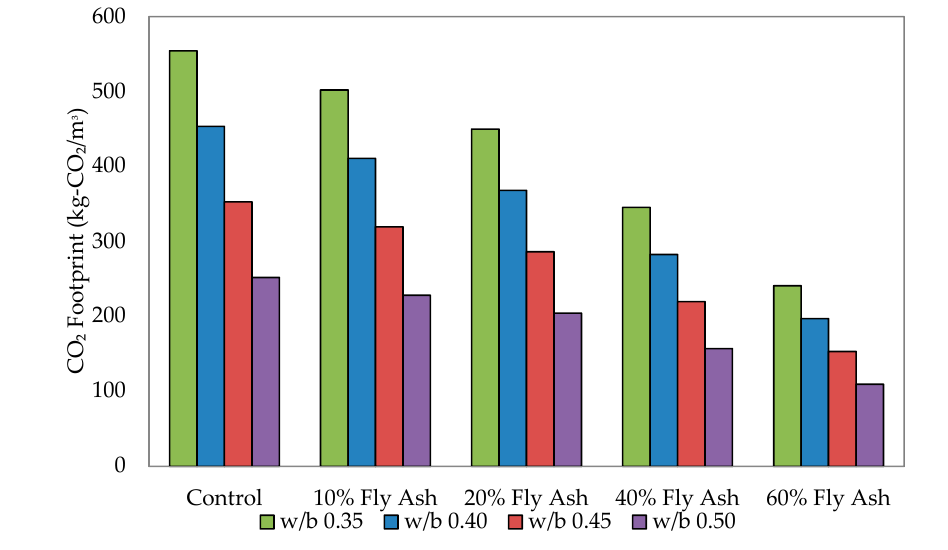
Figure 10. CO 2 footprint of self-compacting mixes.